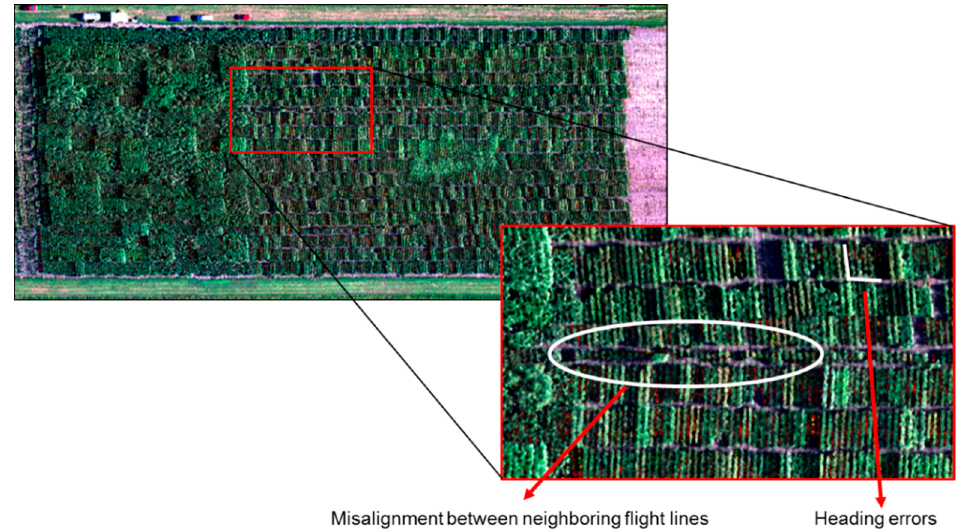
Figure 11. Mosaicked partially-rectified orthophoto of hyperspectral data over the test field captured on 21 August 2015 (only the RGB bands are displayed) showing heading errors and misalignment between neighboring flight lines.